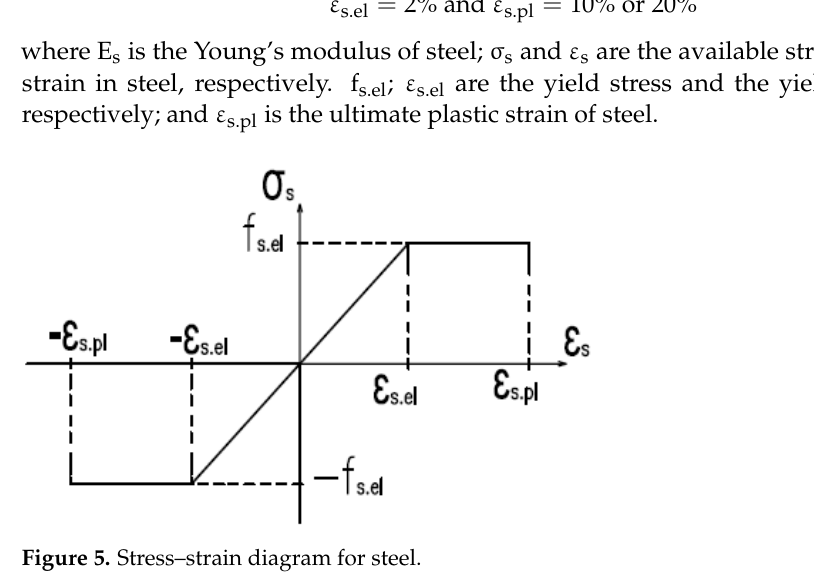
Figure 5. Stress–strain diagram for steel.